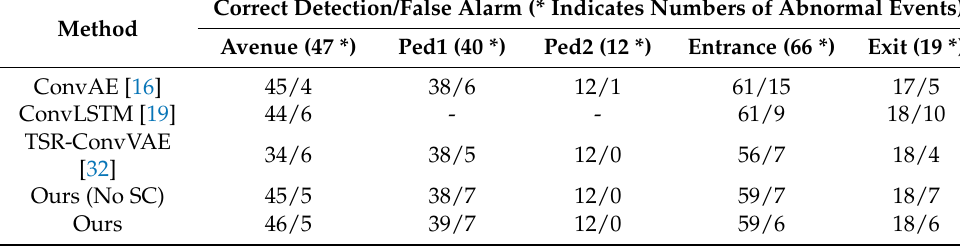
Table 2. Comparison of existing methods on event level. (No SC: indicates the removal of spatial constraints).